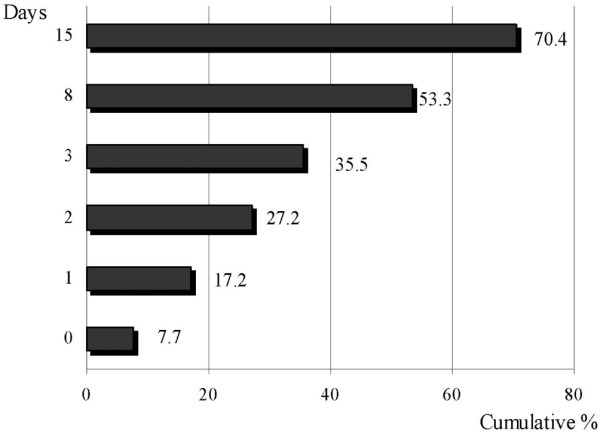
Time course of mortality in non-survivors. Cumulative percentage of non-survivors (n = 169) after diagnosis of severe sepsis.